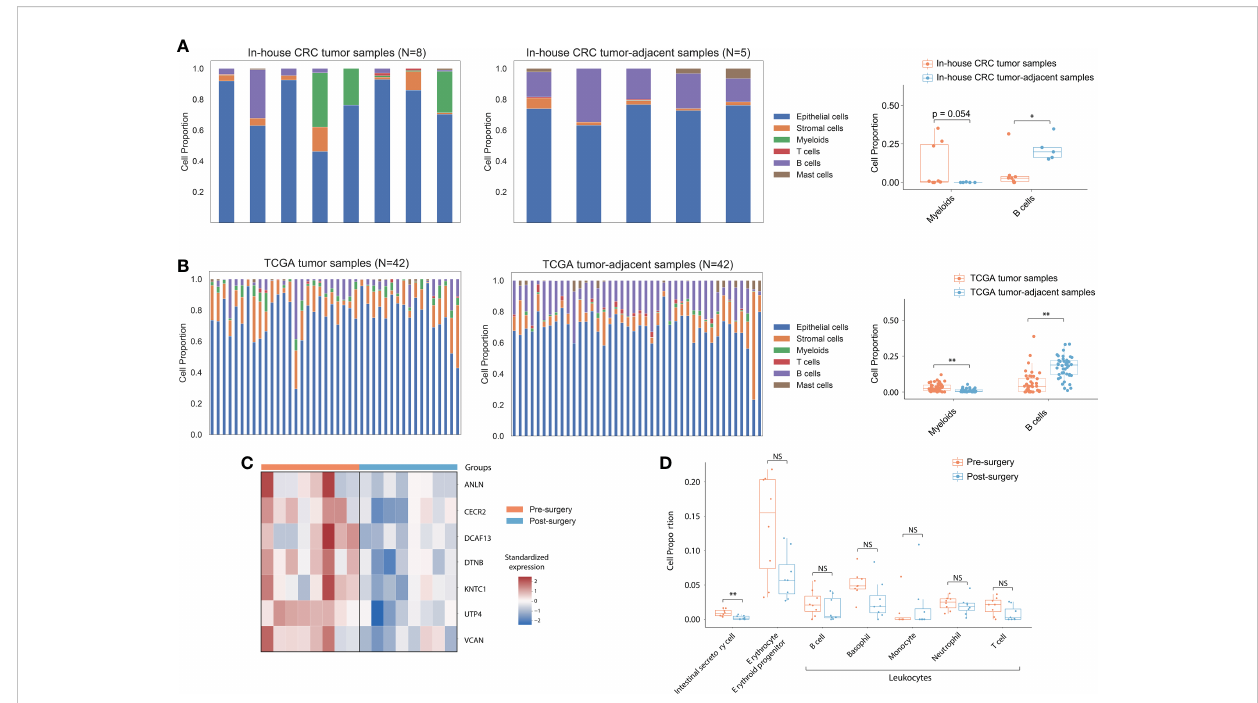
FIGURE 2 Cell type proportion in tissue and cfRNA. (A) Deconvoluted cell type proportion of in-house bulk CRC tumor samples and CRC tumor-adjacent samples. Box plot showed myeloid and B cell fraction distribution from CRC patients. (B) Deconvoluted cell type proportion of 42 TCGA bulk tumor and normal samples. Each stacked bar of the left and middle panels represented matched tumor and normal tissue from a single participant. Box plots showed myeloid and B cell fraction distribution from 42 CRC patients in TCGA. (C) Heatmap of expression for CRC tissue-highly expressed genes in plasma samples. (D) Box plots showed intestinal secretory cells, erythrocytes, erythroid progenitors, and leukocyte fraction distribution from pre- and post-surgical plasma samples. P values from the Wilcoxon rank-sum method indicated signi fi cance levels for differences in cell type proportion across sample groups. “ ** ” represented P<0.01; “ * ” represented P<0.05. NS, not signi fi